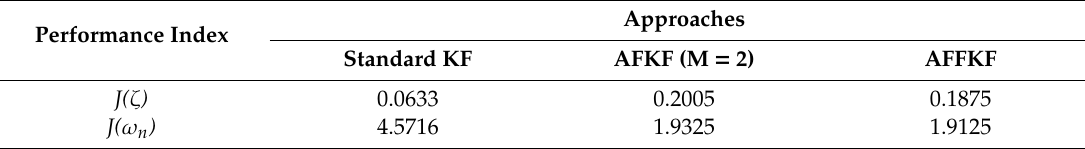
Table 4. Comparison of performance index for estimation of incipient fault parameter.